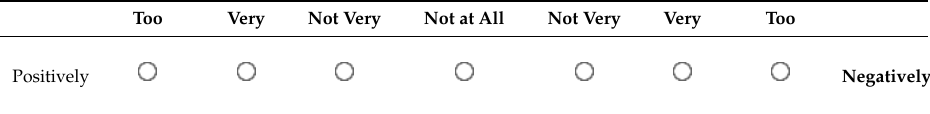
Figure A2. Google Earth aerial images used: ( A ) Freire, ( B ) Lumaco, ( C ) Pucón, ( D ) Curarrehue. (Scale of 1:10,000).